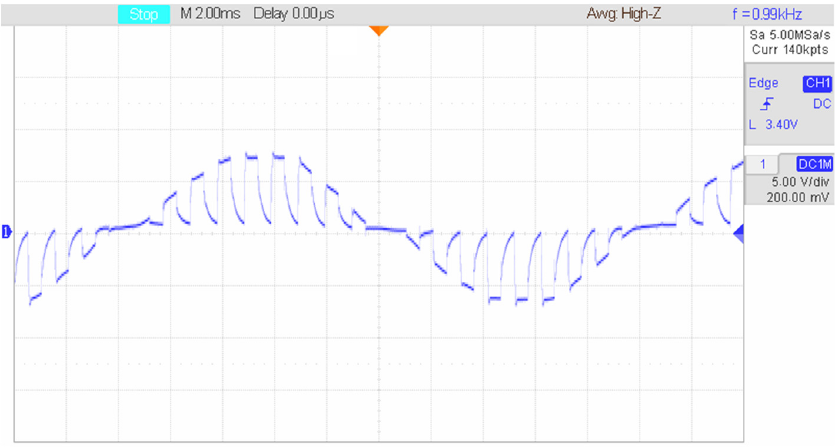
Figure 22. Output voltage waveform.